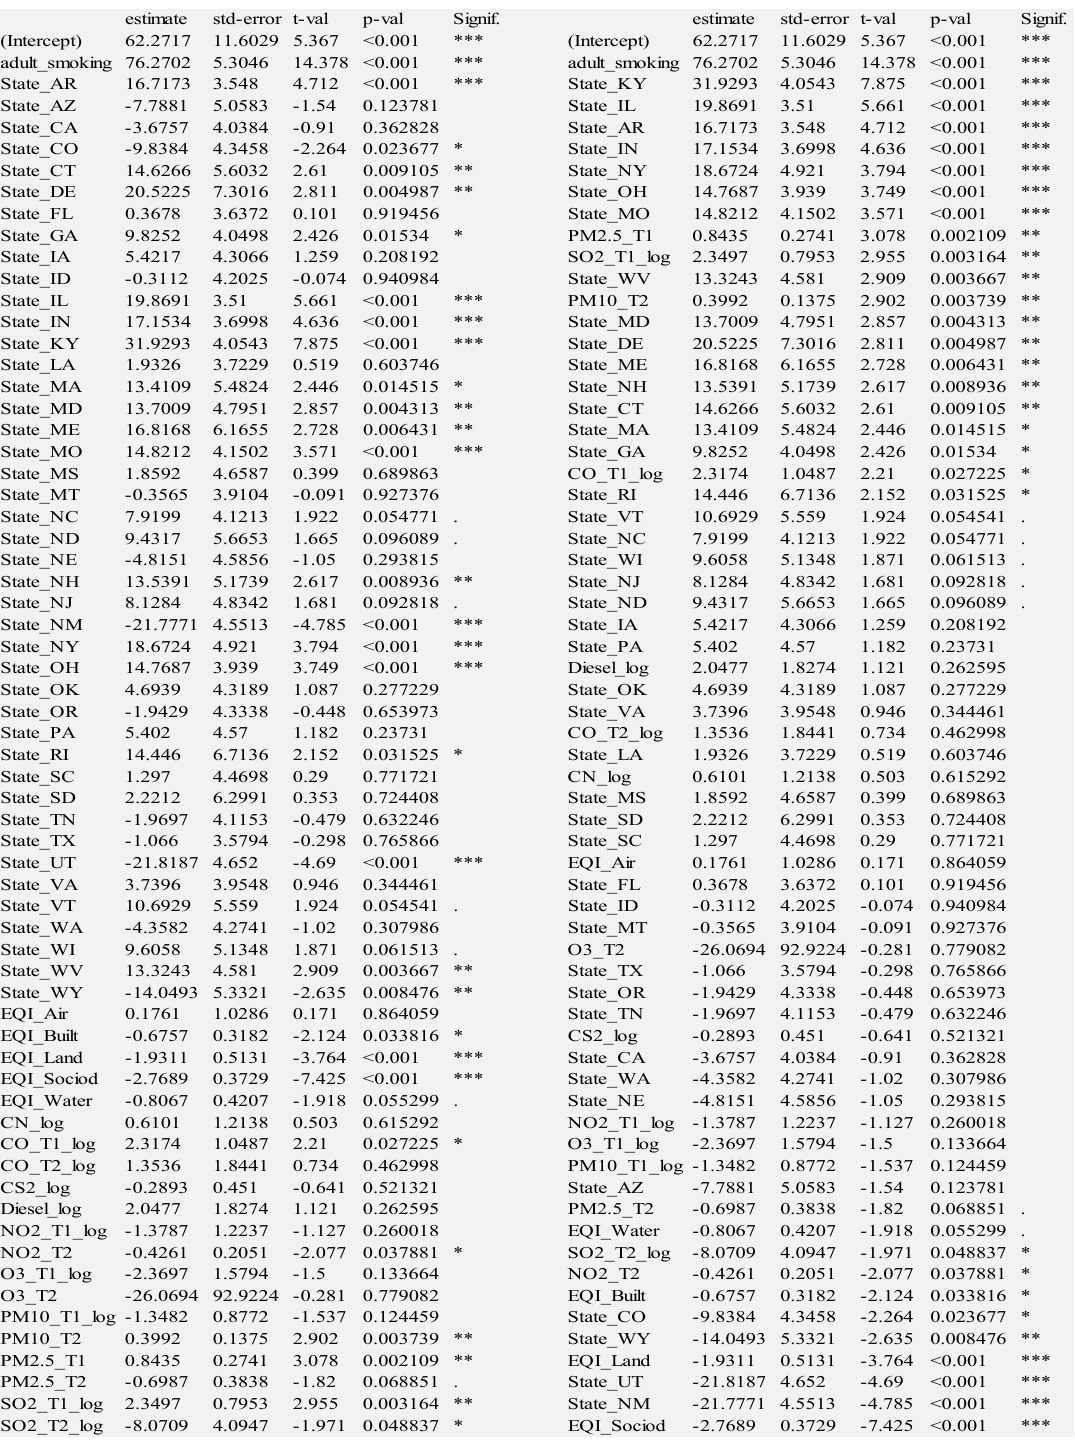
Figure 10. Foundation + EQI + Ambient Emissions; Residual standard error: 10.41 on 2221 degrees of freedom; Multiple R-squared: 0.6285, Adjusted R-squared: 0.6178 ; F-statistic: 58.71 on 64 and 2221 DF, p -value: < 2.2 × 10 − 16 ; Significance codes: 0 ‘***’ 0.001 ‘**’ 0.01 ‘*’ 0.05 ‘.’ 0.1 ‘ ’